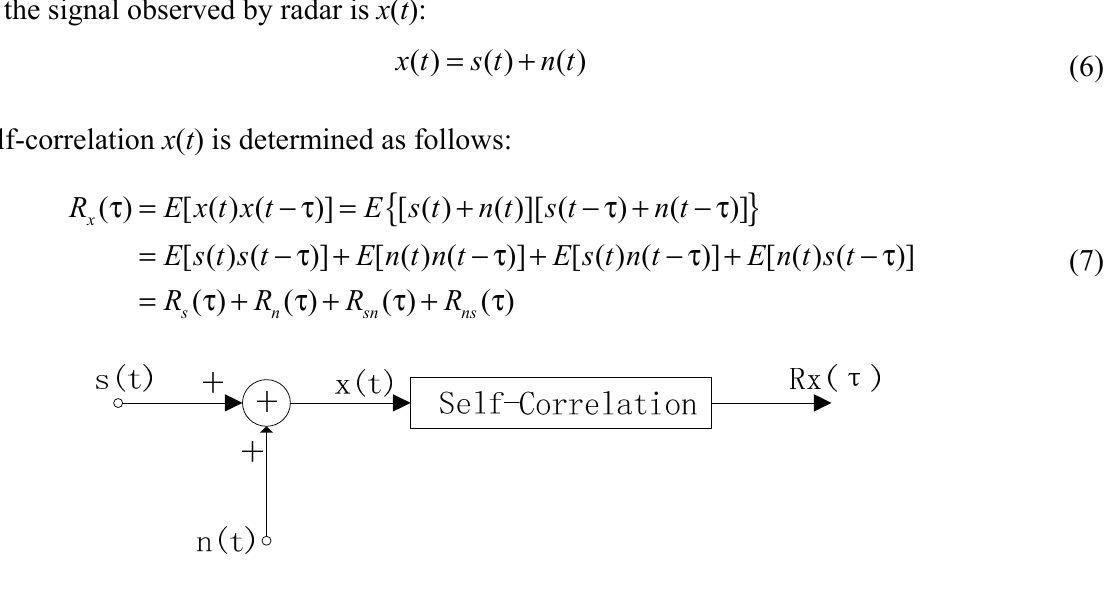
Figure 4. Using self-correlation to extract periodic signal from